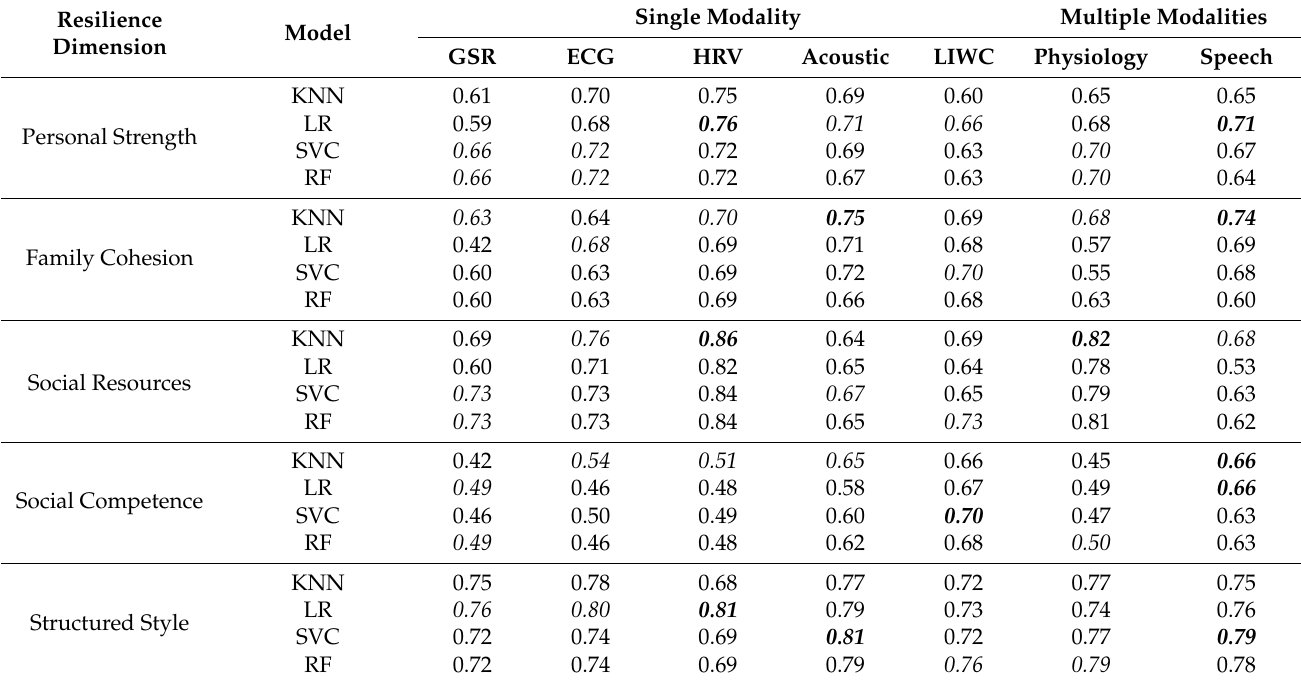
Table 3. Results of Resilience Estimation (only negative memories)